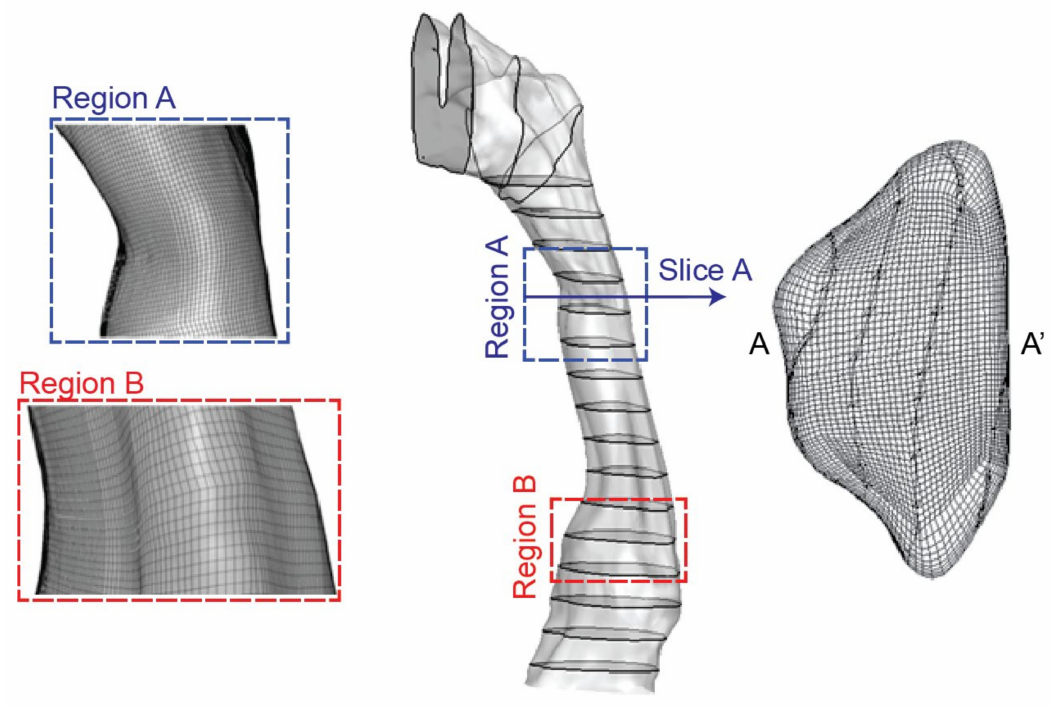
Figure 2. Computational pharyngeal model with cross-section slices and